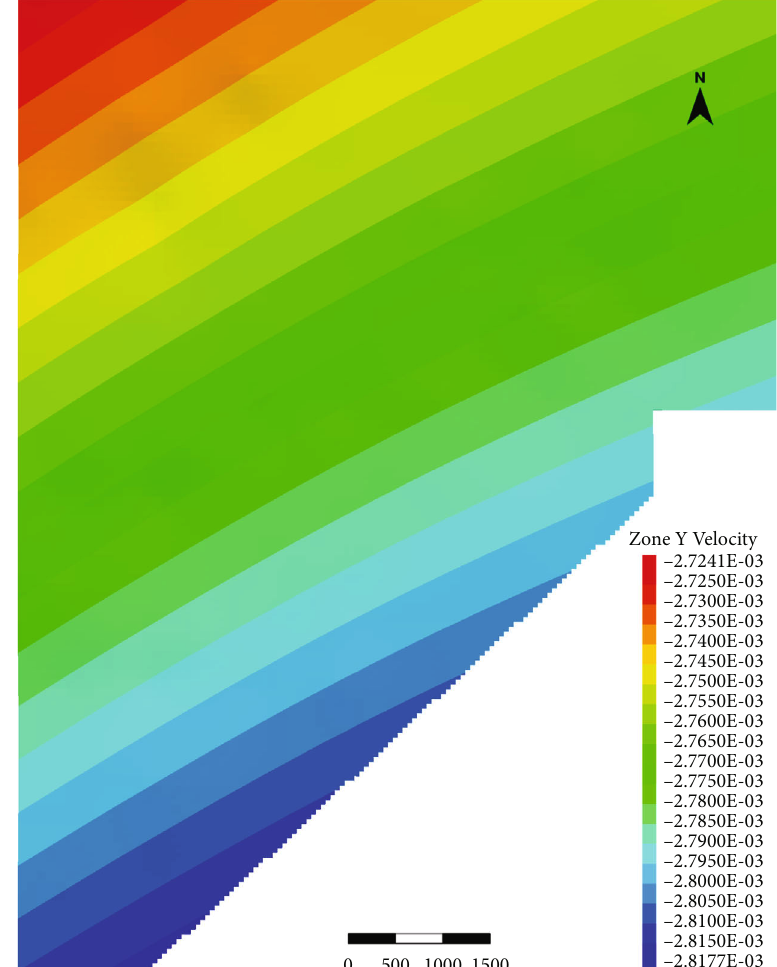
Figure 6: North velocity isogram in the model after applying tectonic stress